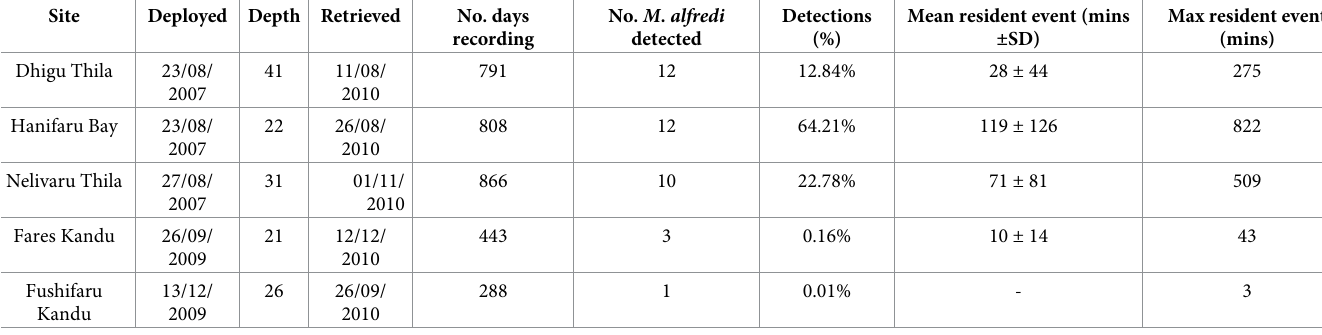
Table 2. Summary of acoustic receiver